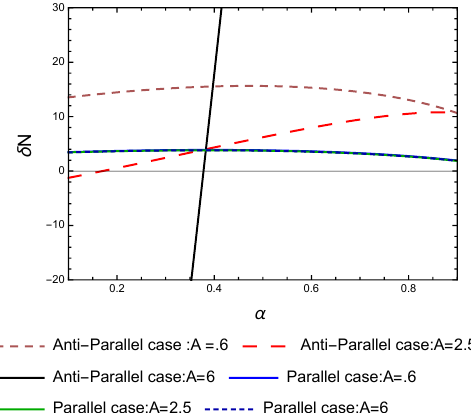
Figure 7 . Parallelly and anti-parallelly accelerating detectors in (1 + 1) dimensions: δ N VS α plot for different fixed values A with ∆ E = 1 . All the parallel plots are very close to one another like in a B the previous figures.